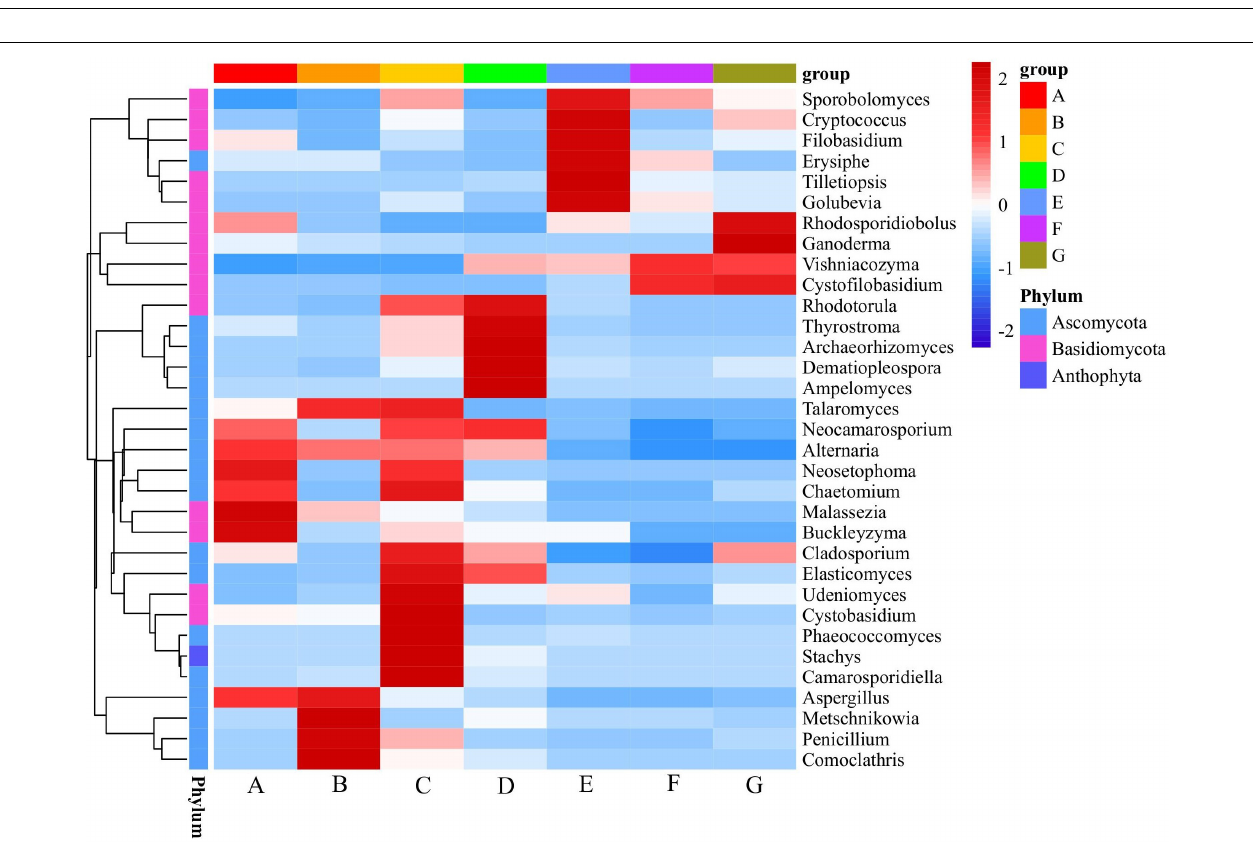
FIGURE 6 | The relative abundance of fungal communities at the genus level.